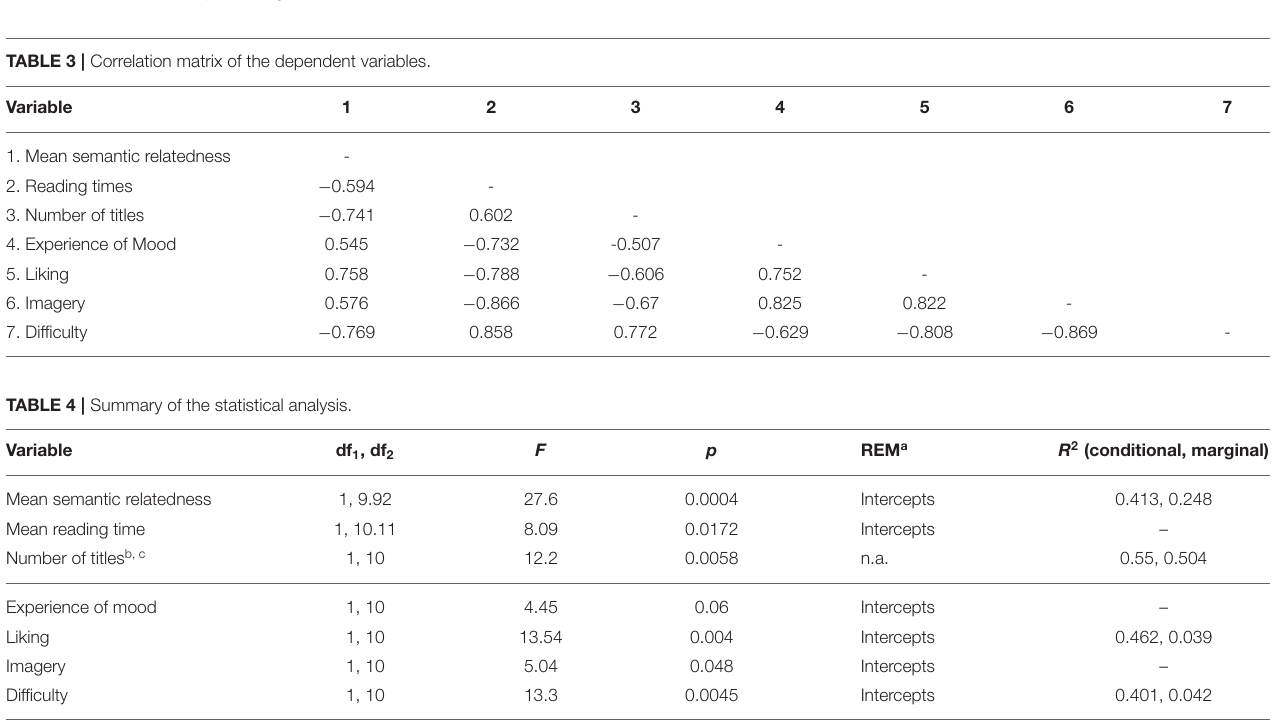
TABLE 2 | Dimensions assessed and corresponding items in the poem questionnaire. Dimension Item Liking I like the poem. Experience of Mood Reading the poem let me experience a mood. Imagery Difficulty